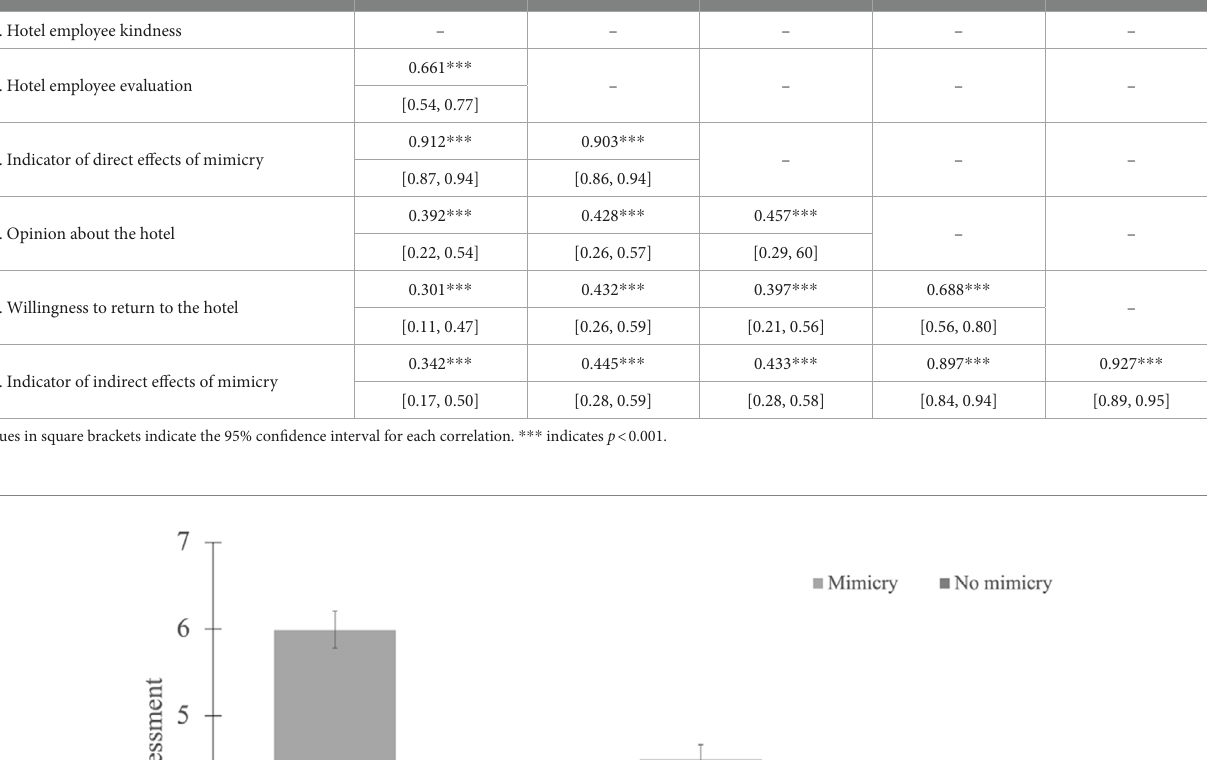
TABLE 4 Spearman’s rho correlation matrix between all individual factors with confidence intervals (Main Experiment). Variable